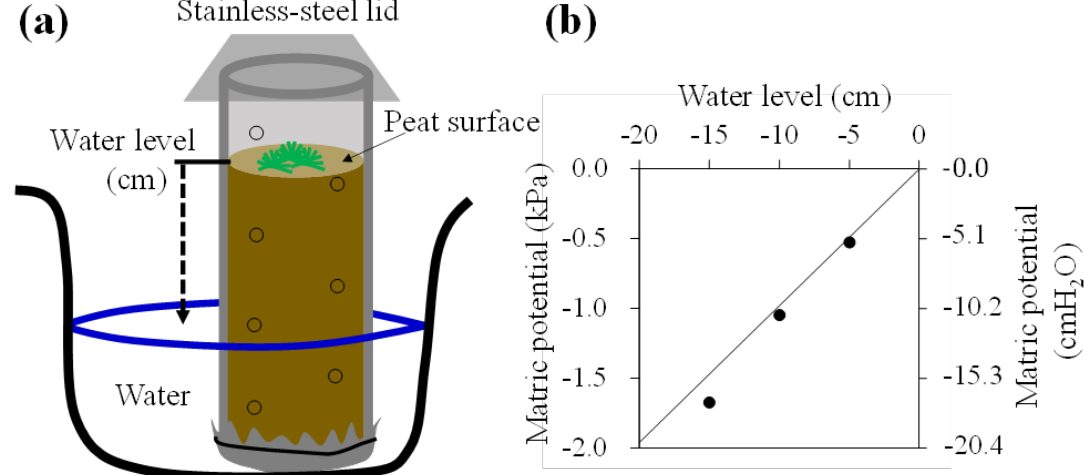
Figure 2. Moisture-control equipment: (a) schematic diagram of the equipment, and (b) the relationship between water level and equilibrium matric potential at the peat surface. The line in panel (b) shows how the equilibrium matric potential of soil water at the surface varies with water